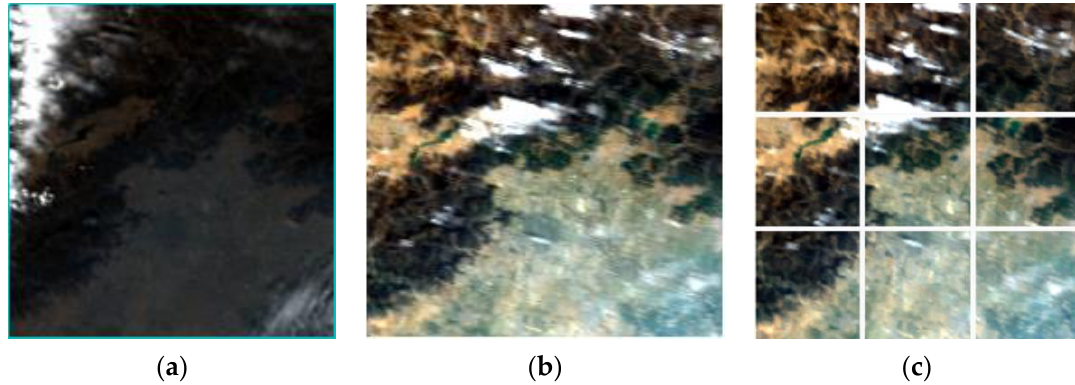
Figure 1. ( a ) is the satellite image with full channel information, and ( b ) is the synthesized RGB image. ( c ) is cut into nine equally sized blocks based on ( b ). Table 1. Spatial resolution and wavelength interval of each channel in MOD021KM.